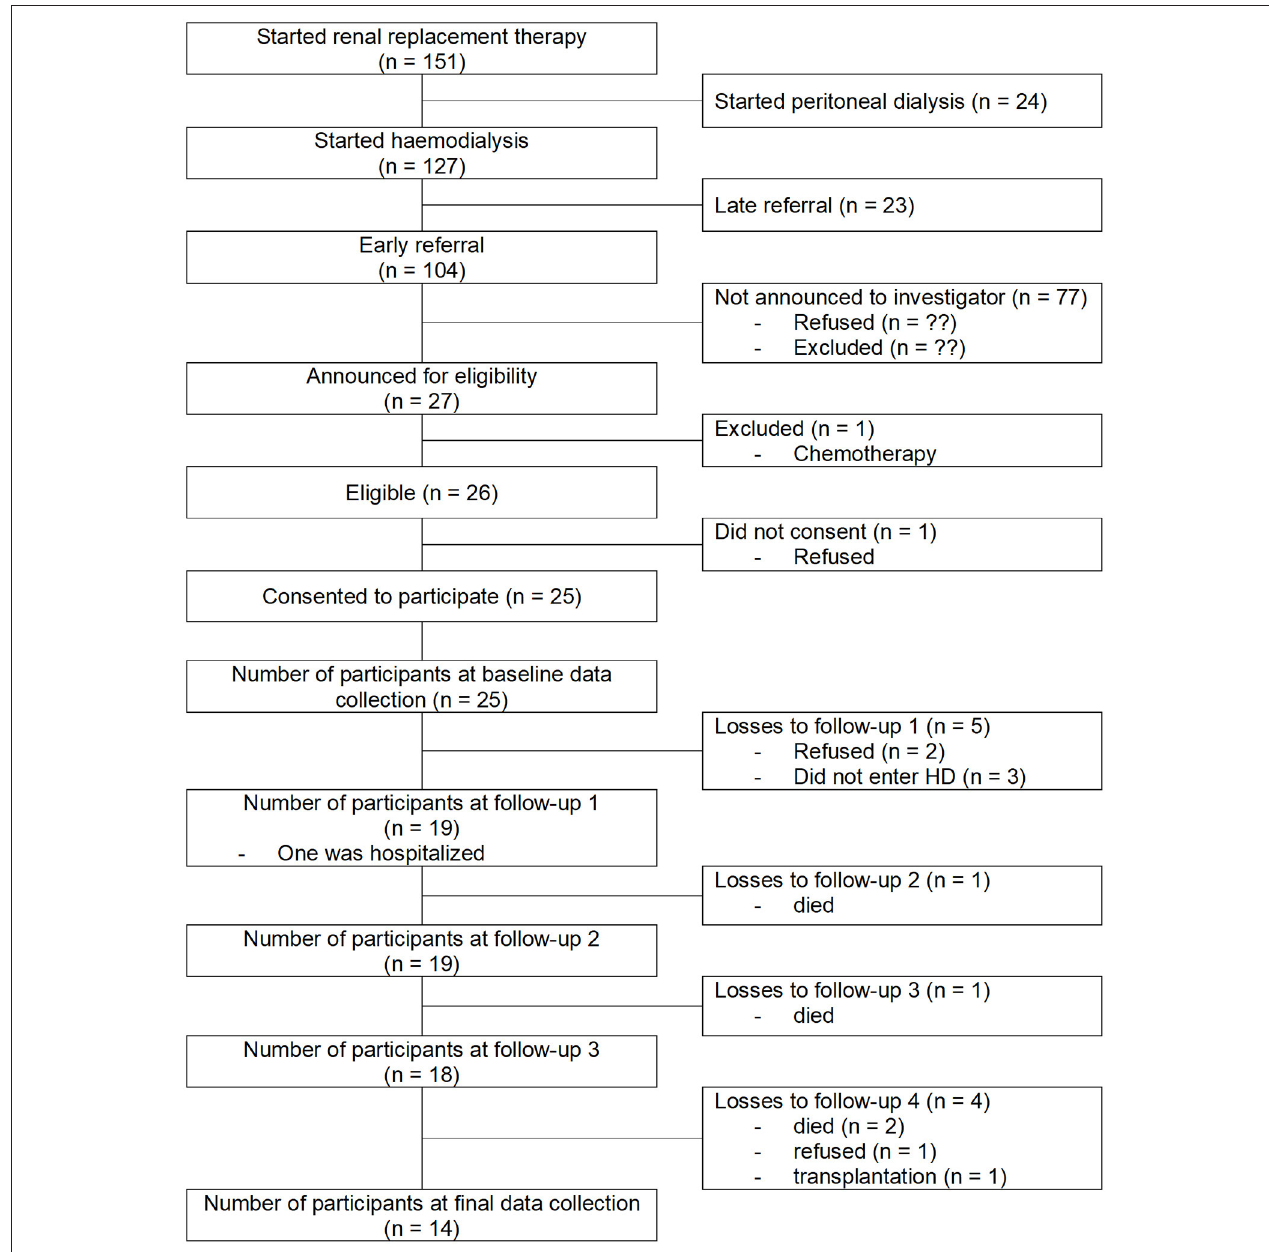
FIGURE 1 | Study flow